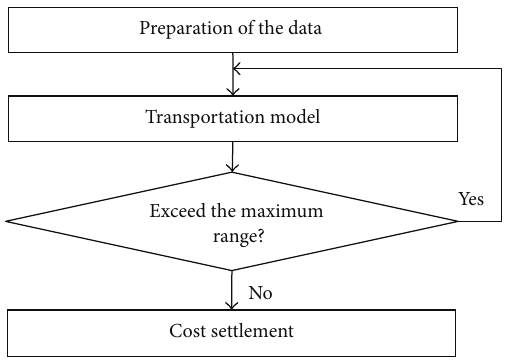
Figure 4: Power supply range by the transport